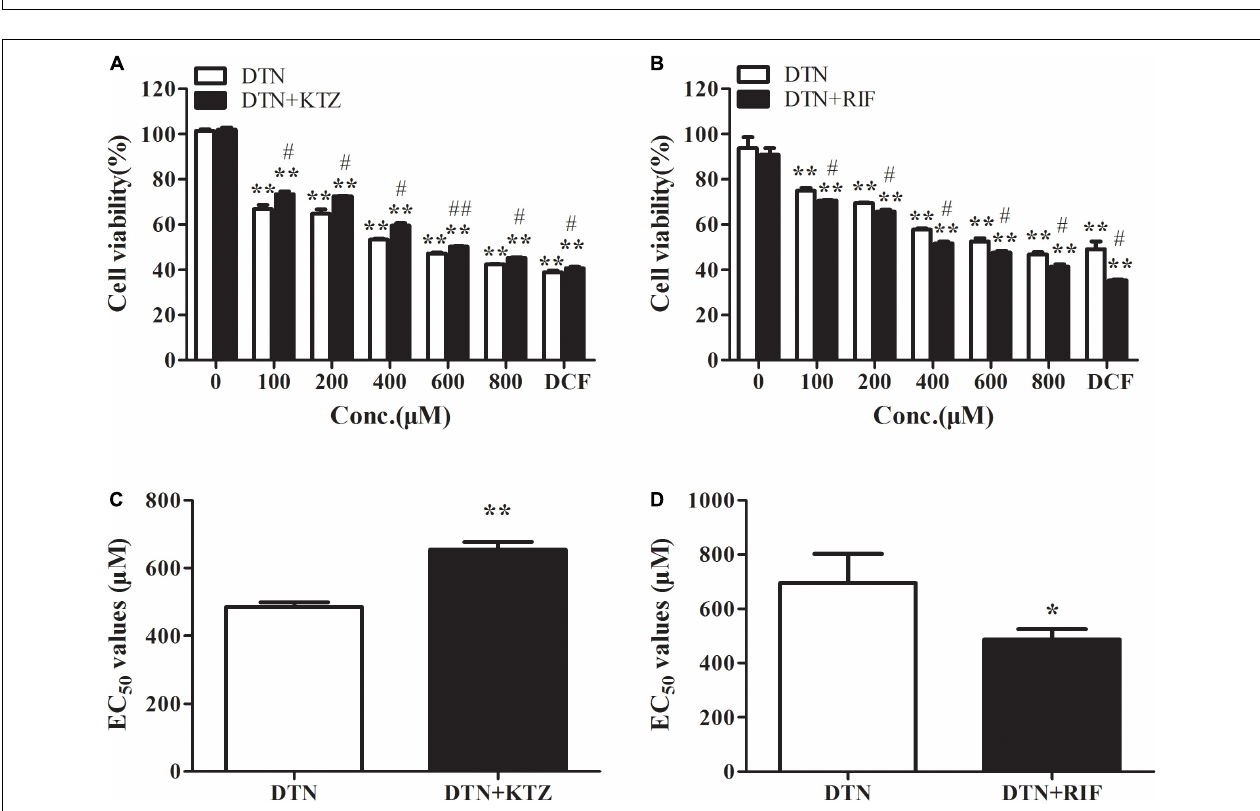
FIGURE 4 | The effect of inhibition and induction of CYP3A4 on the cytotoxicity of DTN in PHH pretreated with KTZ (A,C) and RIF (B,D) , respectively. Data are represented as mean ± SD ( n = 3). ∗ p < 0.05, ∗∗ p < 0.01 vs. control group; # p < 0.05, ## p < 0.01 vs. DTN group.